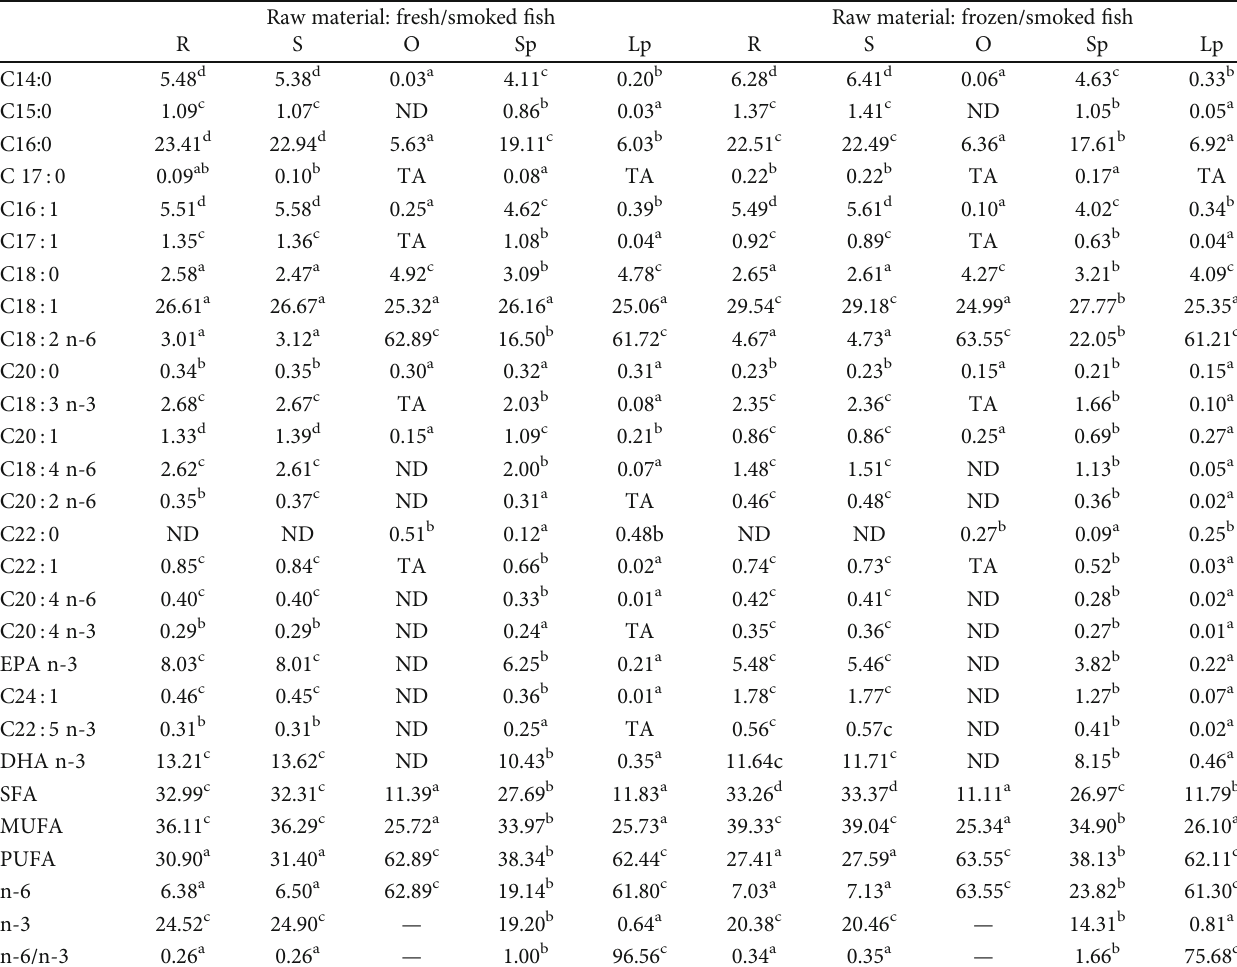
Table 3: Composition of fatty acids (%) in the raw materials (raw fi sh, smoked fi sh, and oil) and solid and liquid parts of canned smoked